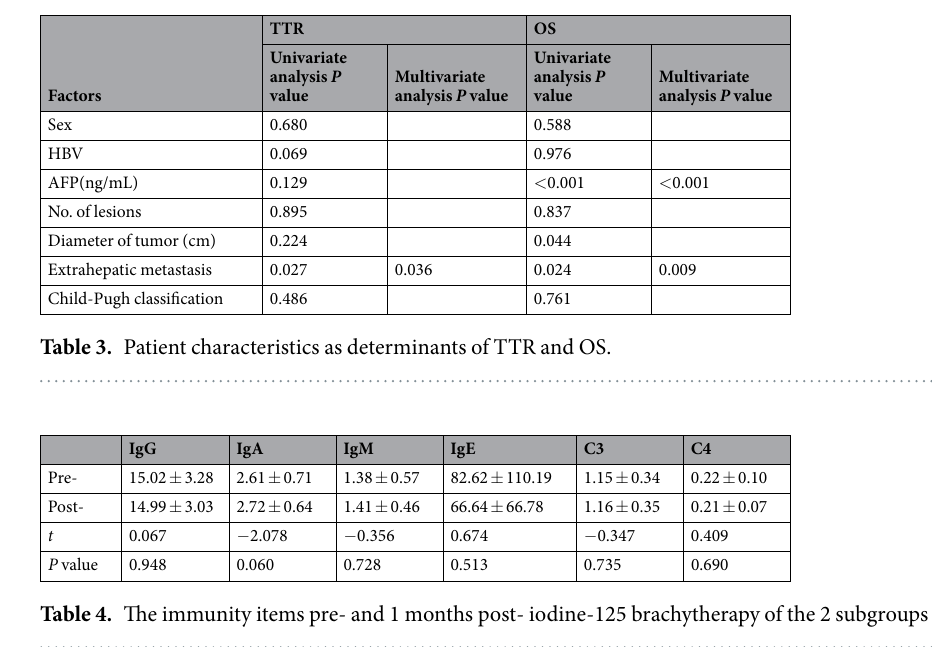
therapeutic effect on the thermal-damaged lesions due to the synergistic effect of radiotherapy and thermother- apy. More importantly, the killing radius of 125 I is short (1.7 cm), which almost has no effect on the normal tissues around the lesions 18, 25 . Patients of this study were in high risk of locoregional tumor recurrence, and received